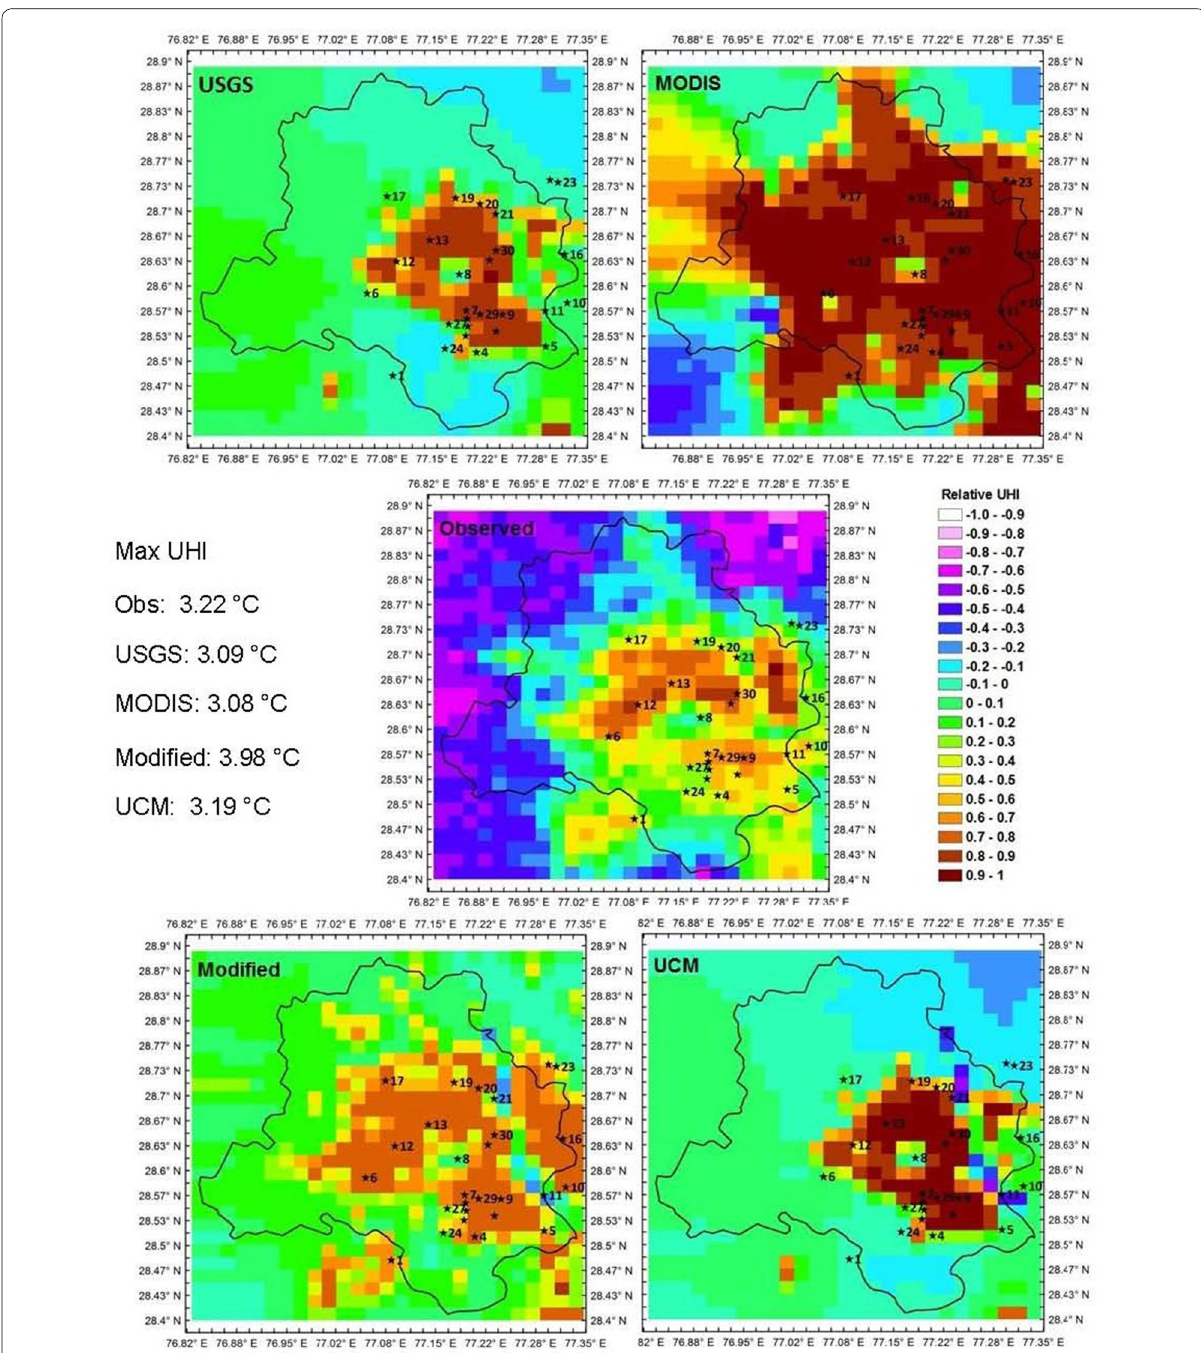
Fig. 10 Nighttime distribution of relative surface heat island